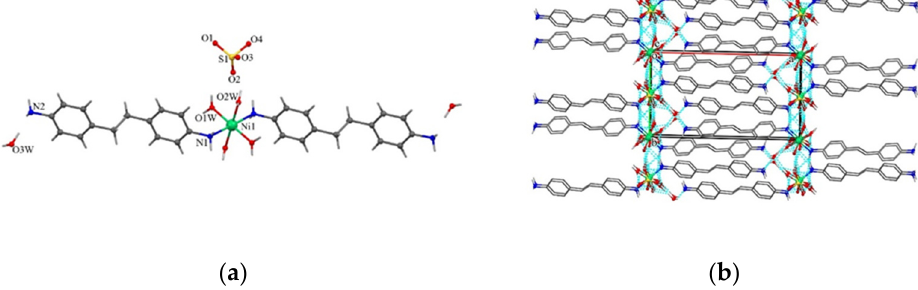
Figure 3. Compound 2 . ( a ) View of complex 2 with partial labelling scheme. ( b ) Crystal packing with indication of principal hydrogen bonds .